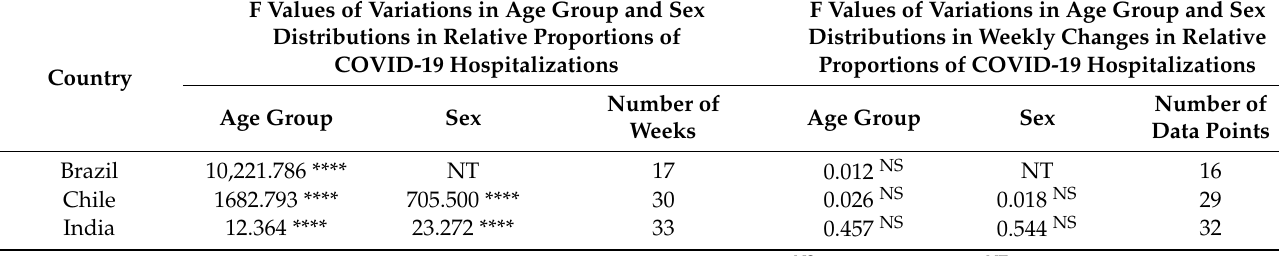
Values in Table 1 are F values. p values are indicated by * for <0.05, ** for <0.01, *** for <0.001, and **** for <0.0001. NS for not significant, NT for not tested. Table 2. Summary F values for variations among age groups and between the two sexes in relative proportions of COVID-19 hospitalizations and in weekly changes between successive weeks in the relative proportions of COVID-19 hospitalizations in three countries. F Values of Variations in Age Group and